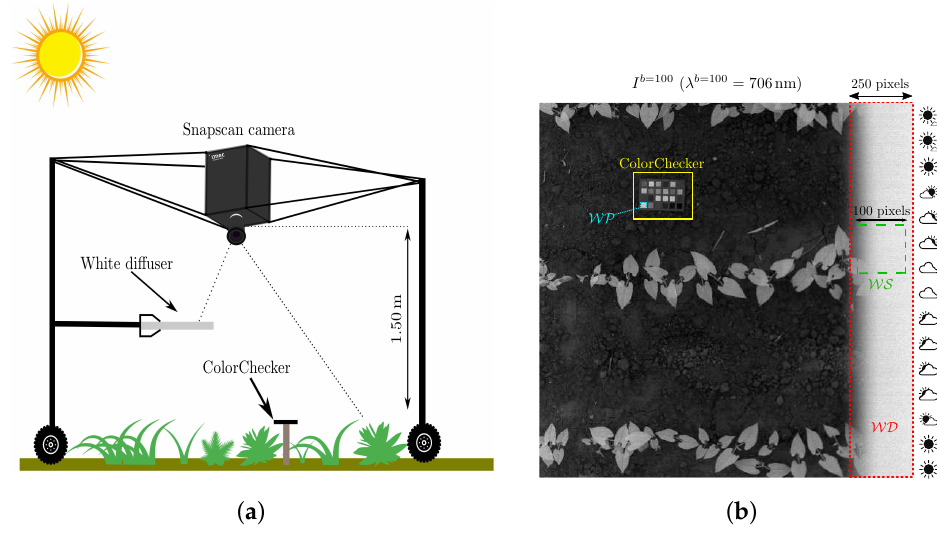
Figure 3. ( a ) The acquisition setup with the camera mounted on its top. ( b ) Channel of a radiance image with the ColorChecker and a white diffuser along its right border. Pixel subsets and are displayed in red, green, and cyan, WP